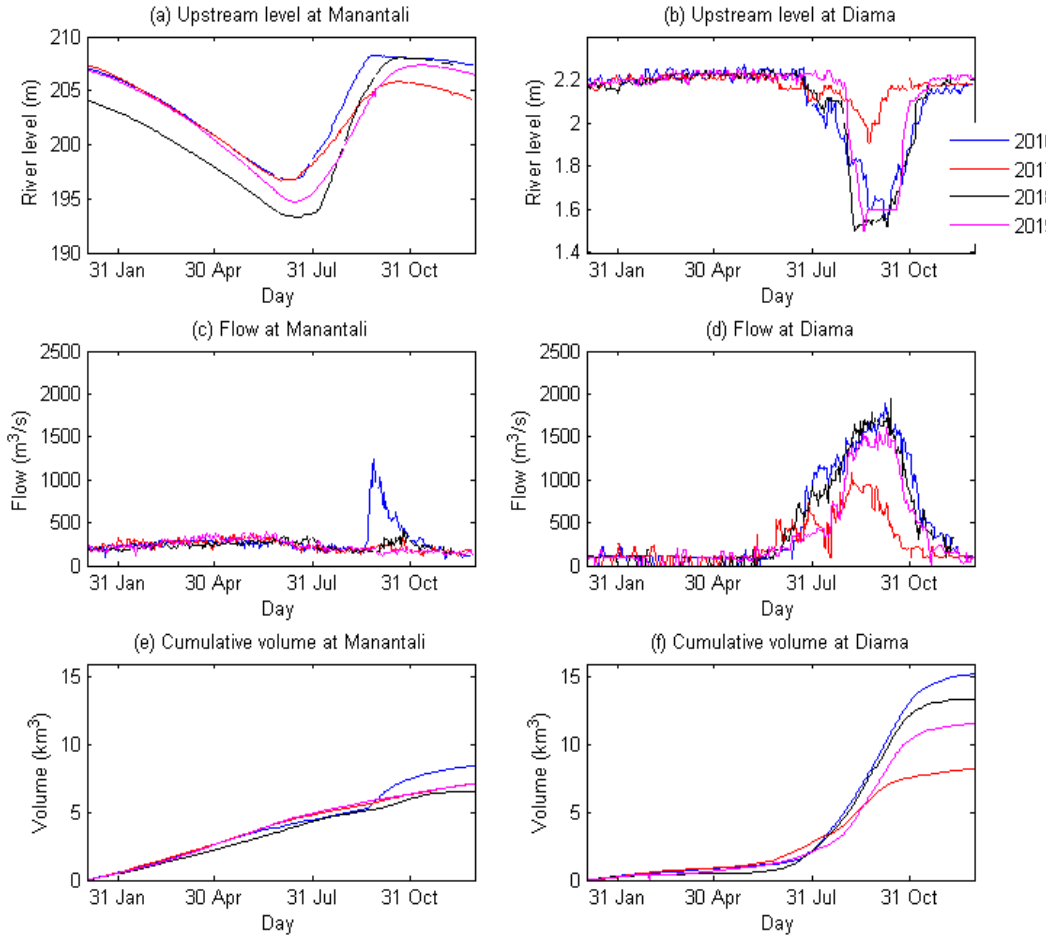
Figure 5. River levels ( a , b ), Flows ( c , d ) and volumes ( e , f ) at the Manantali and Diama dams (2016–2019). Data source: Regional Hydraulic Division of Saint-Louis/Senegal.